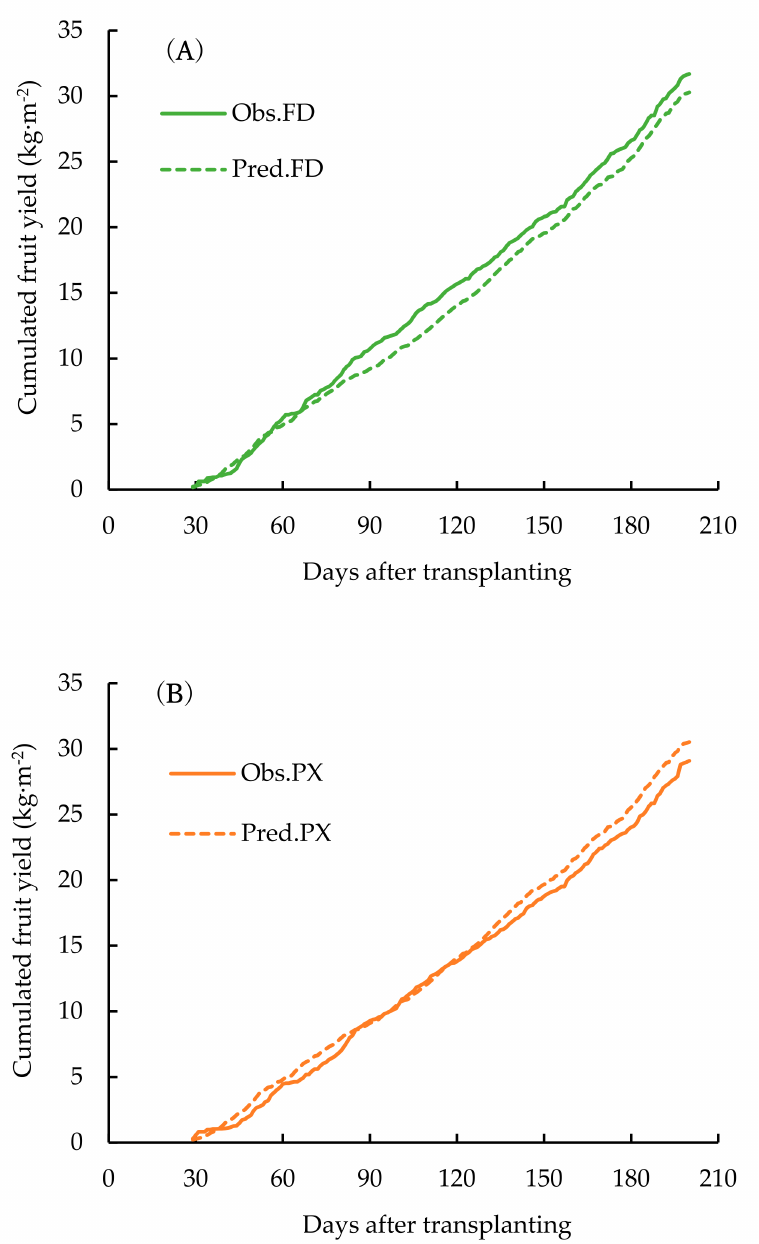
Figure 7. Predicted and observed cumulative fresh fruit yields in two cucumber cultivars. ( A ) “Fresco-dash”; ( B ) indicate “Project X”. The fruits were observed daily and harvested when they reached approximately 100 g ( n =